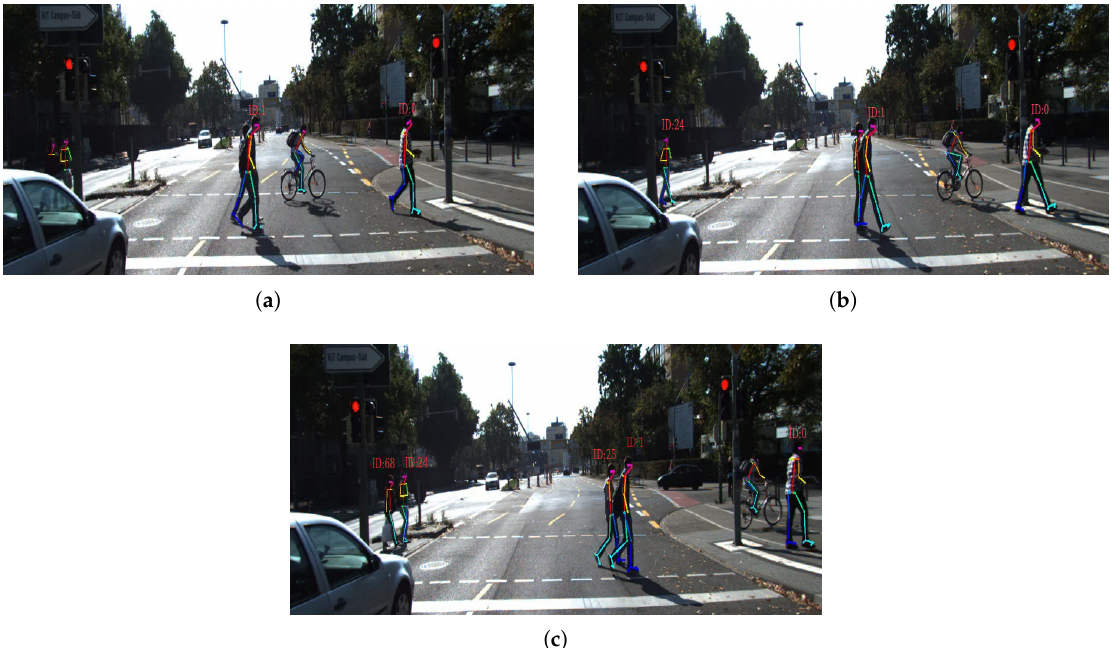
Figure 10. In ( a ), one pedestrian occludes another one, and the legs of two pedestrians are occluded by a car. In ( b ), one of the occluded pedestrians is in the field of view of the camera. In ( c ), OpenPose detects their joints. In situations such as ( a ) and ( b ), OpenPose can not detect pedestrians, affecting the results of Multiple Object Tracking Precision (MOTP).